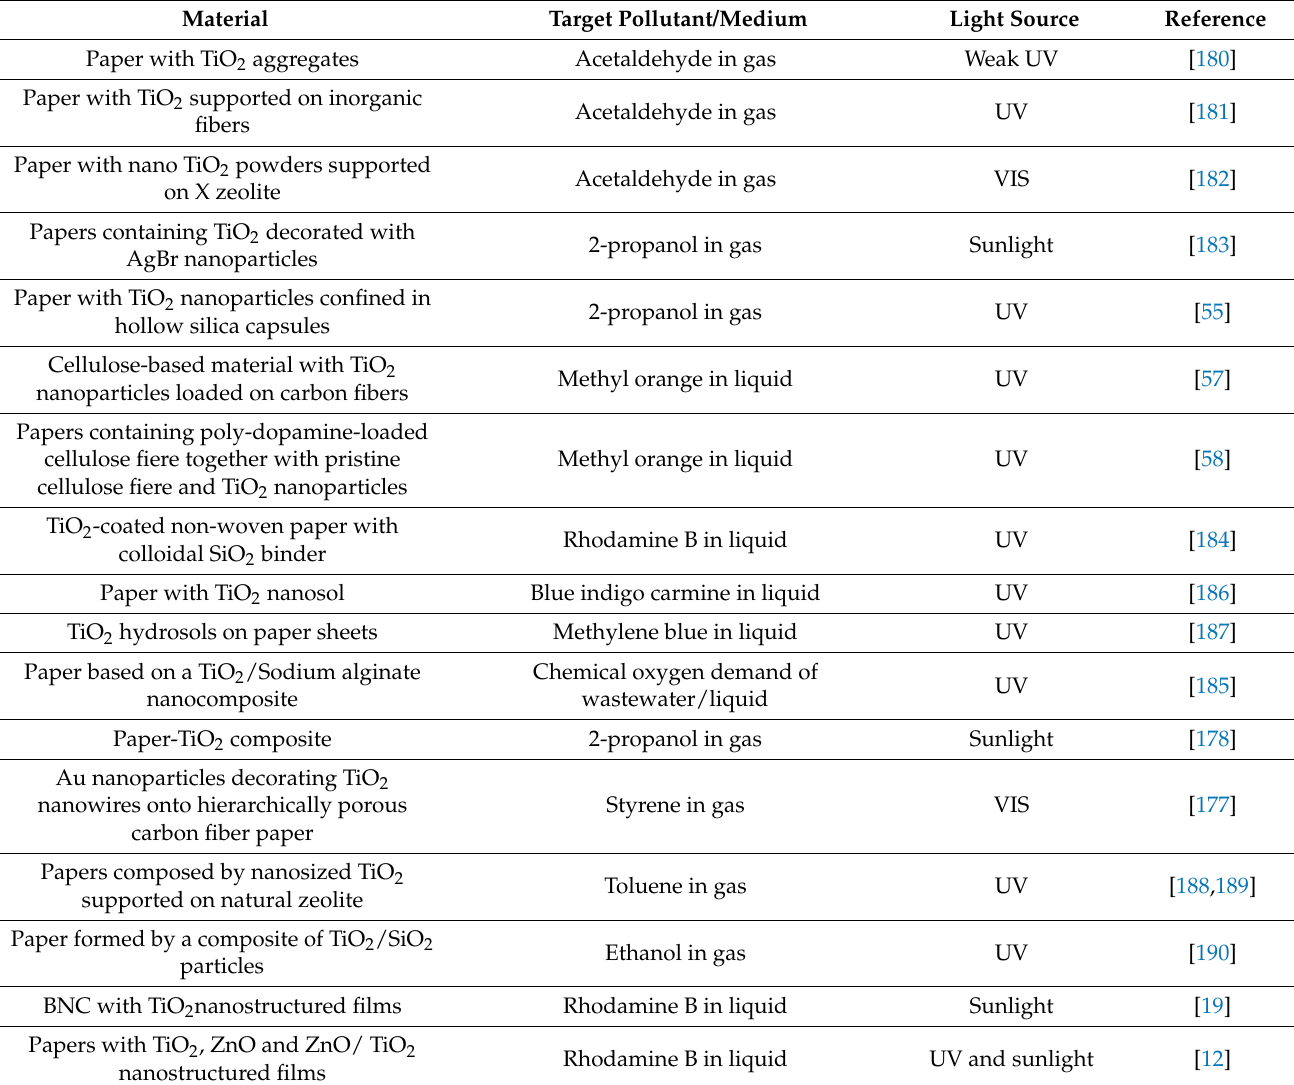
Table 1. Summary of the metal oxide-based photocatalytic papers reported in